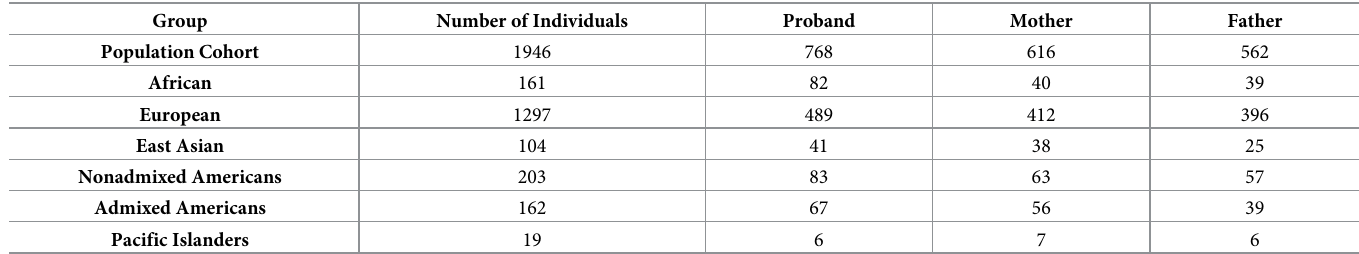
Table 1. Demographic breakdown.